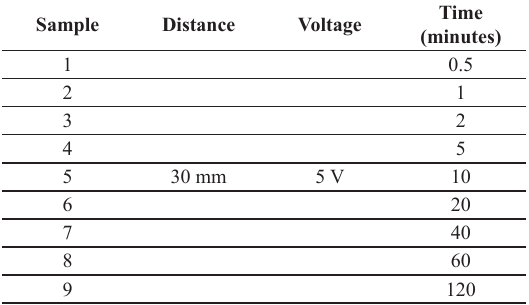
Table 1. Parameters